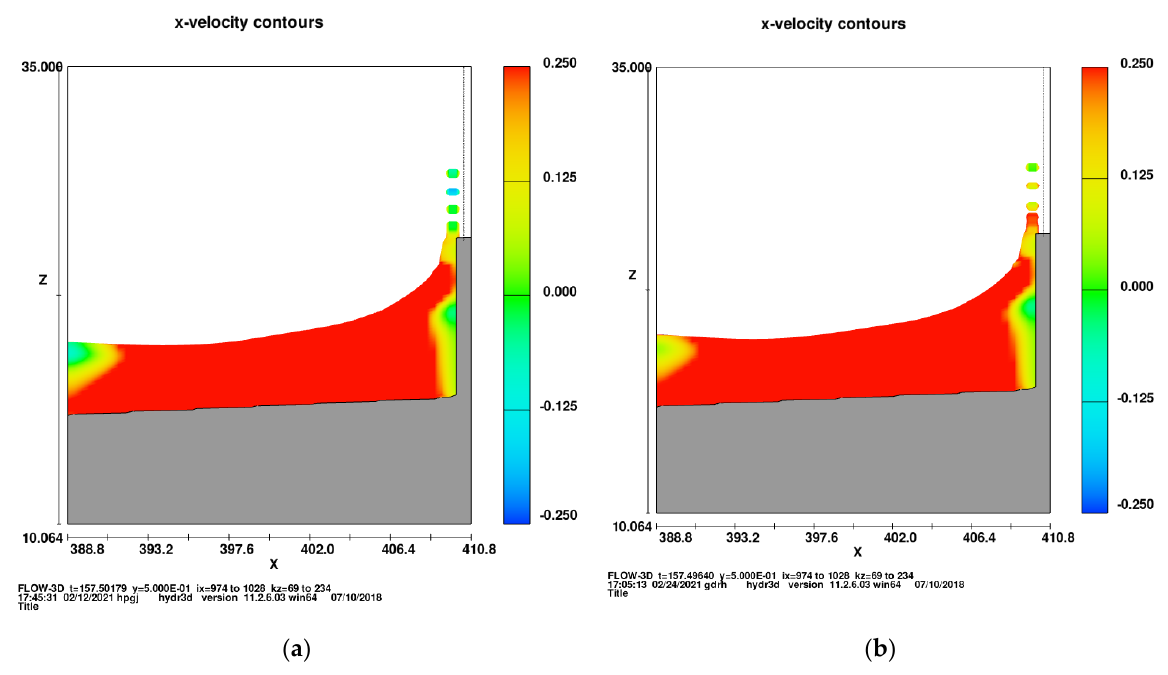
Figure 15. TEST_3 and Rc = +7.00 m. Panel ( a ) no wind; panel ( b ) U 10 31.2 m/s.